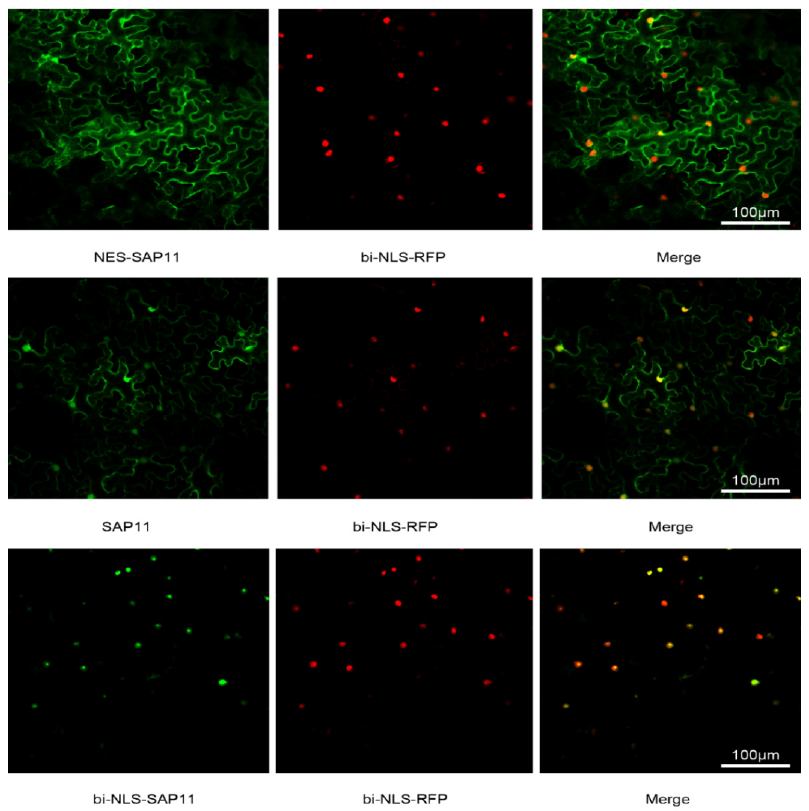
Figure 1. Transient expression of SAP11 PM19 , NES- and bi-NLS-SAP11 PM19 in wt N. benthamiana . SAP11 PM19 , NES- and bi-NLS-SAP11 PM19 were fused to GFP and bi-NLS fused with RFP to mark the nucleus. The proteins were transiently expressed in N. benthamiana via Agrobacterium -infiltration. The localization of expressed proteins was analyzed by confocal microscopy using GFP and RFP filters. The result in Figure 1 shows that SAP11 PM19 -GFP (SAP11) localizes not only in the plant nucleus but also in the cytoplasm (middle panel) whereas NES (NES-SAP11, upper panel) and bi- NLS SAP11 PM19 -GFP (bi-NLS-SAP11, lower panel) were localized exclusively in the cytoplasm and nucleus, respectively. Co-localization with bi-NLS-RFP is indicated by yellow coloring in the